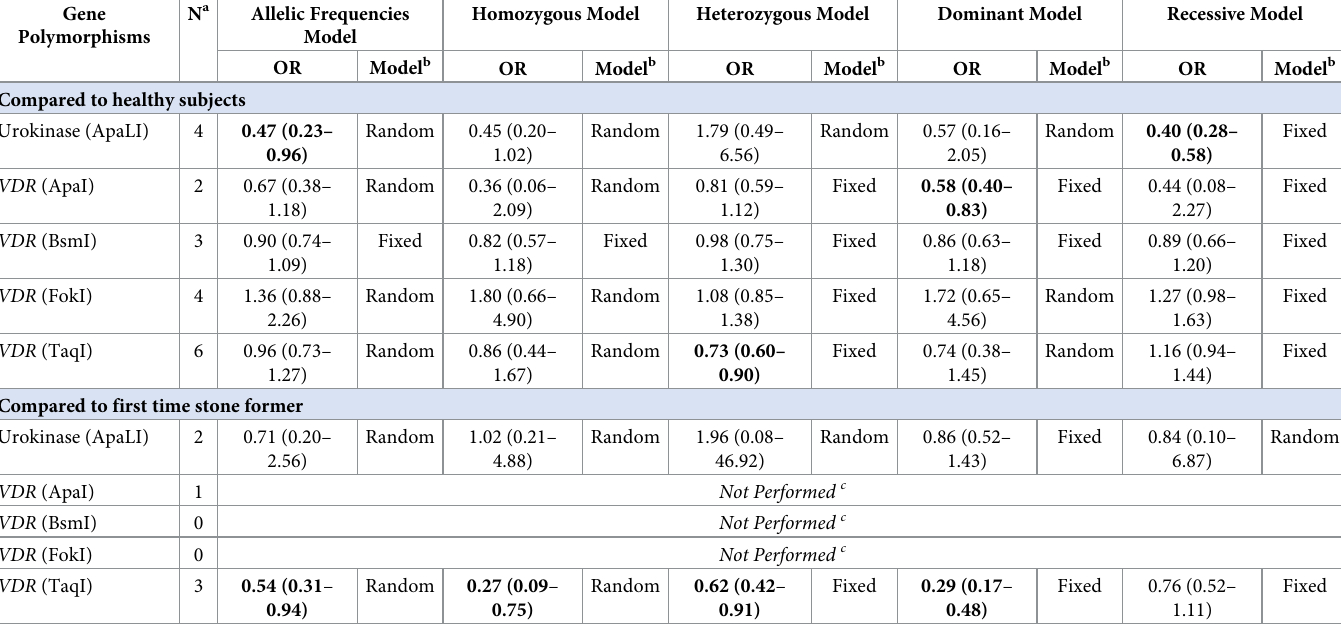
Table 5. Pooled OR analysis between the urokinase (ApaLI) and VDR (ApaI, BsmI, FokI, and TaqI) gene polymorphisms and recurrent kidney stones among larger studies (N > 200